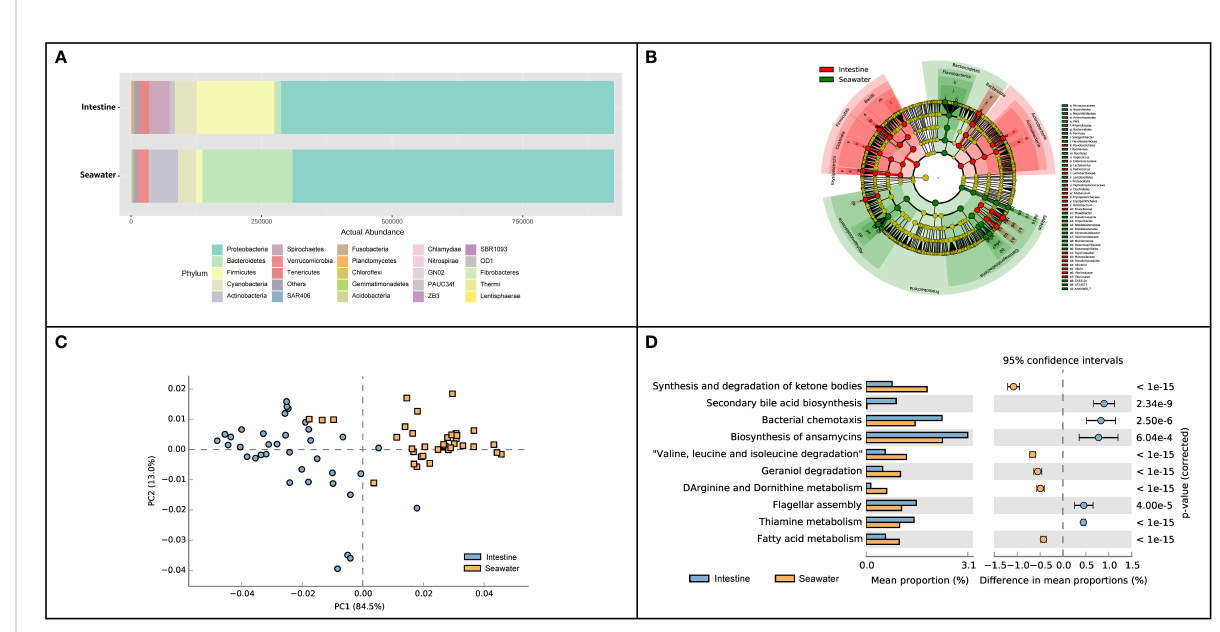
FIGURE 4 Composition and function differences between intestinal and seawater bacterial communities. (A) Bacterial abundance at the phylum level; (B) LEfSe analysis of ASVs between intestinal and seawater bacterial communities; (C) Principal components analysis (PCA) of bacterial functional characterization; (D) The differences of functional pathways between intestinal and seawater bacterial